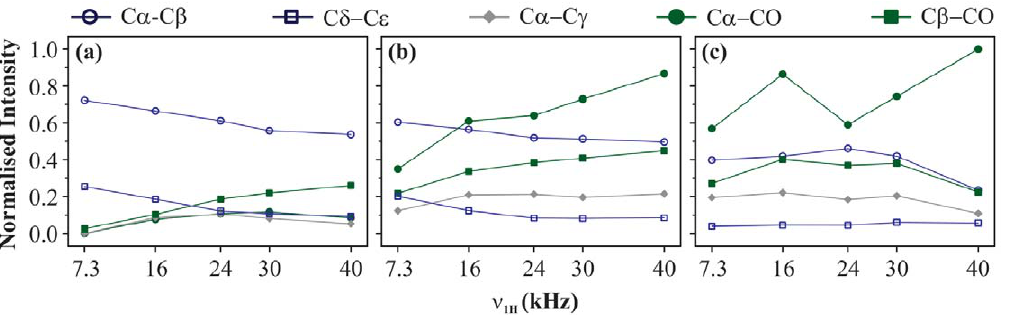
Figure 5. Build-up curves. Magnetisation build-up curves obtained using (a) PARIS (N=1/2), (b) PARIS-xy (m=1)(N=1/2), and (c) PARIS (N=2) recoupling schemes for different cross-peaks of U- 13 C-, 15 N-L-histidine : H 2 O, at n r =30 kHz and B 0 =11.74 T. Each recoupling scheme was applied for a fixed mixing-time period (90 ms) using different RF amplitudes of 7.3, 16, 24, 30, and 40 kHz. M values calculated for individual cross-peaks according to Eq. 1 are plotted as a function of RF amplitude. All M values are normalised with respect to the maximum value yielded by PARIS (N=2) using a RF amplitude of 40 kHz. Data points are joined with straight lines to guide the readers’ eyes.